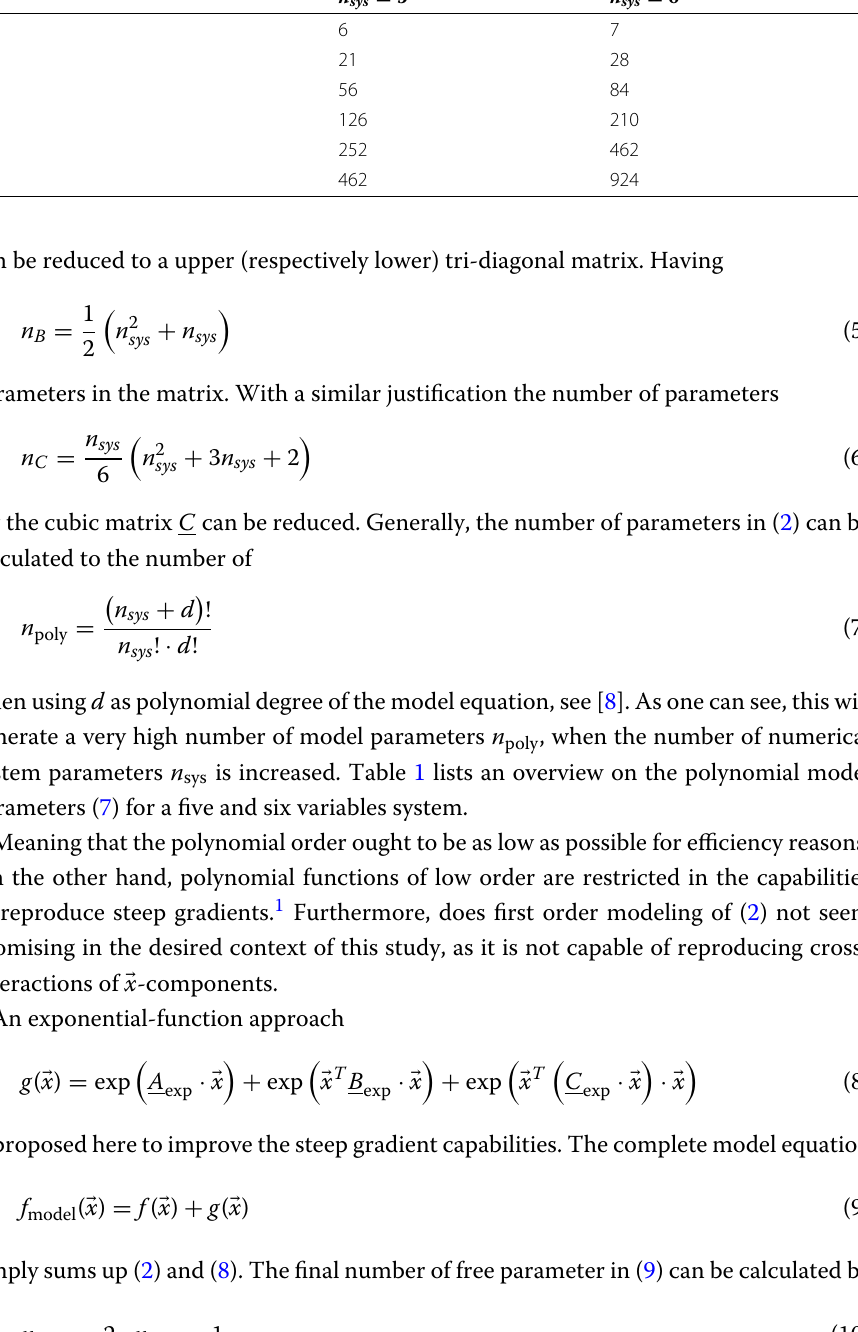
Table1 Number of model parameters for 5 and 6 system-parameter-problem Polynomial-degree Number of model parameters n poly for n sys = 5 n sys =